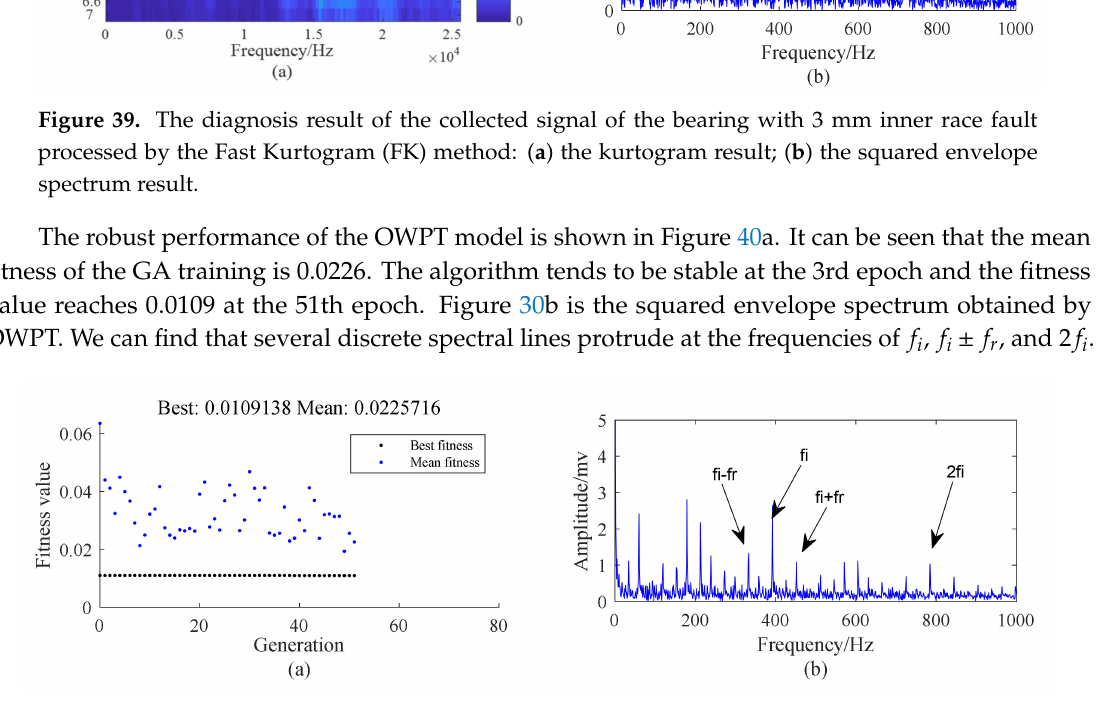
Figure 40. The diagnosis result of the collected signal of the bearing with 3 mm inner race fault processed by Optimal Wavelet Packet Transform (OWPT): ( a ) the training performance of the OWPT; ( b ) the squared envelope spectrum